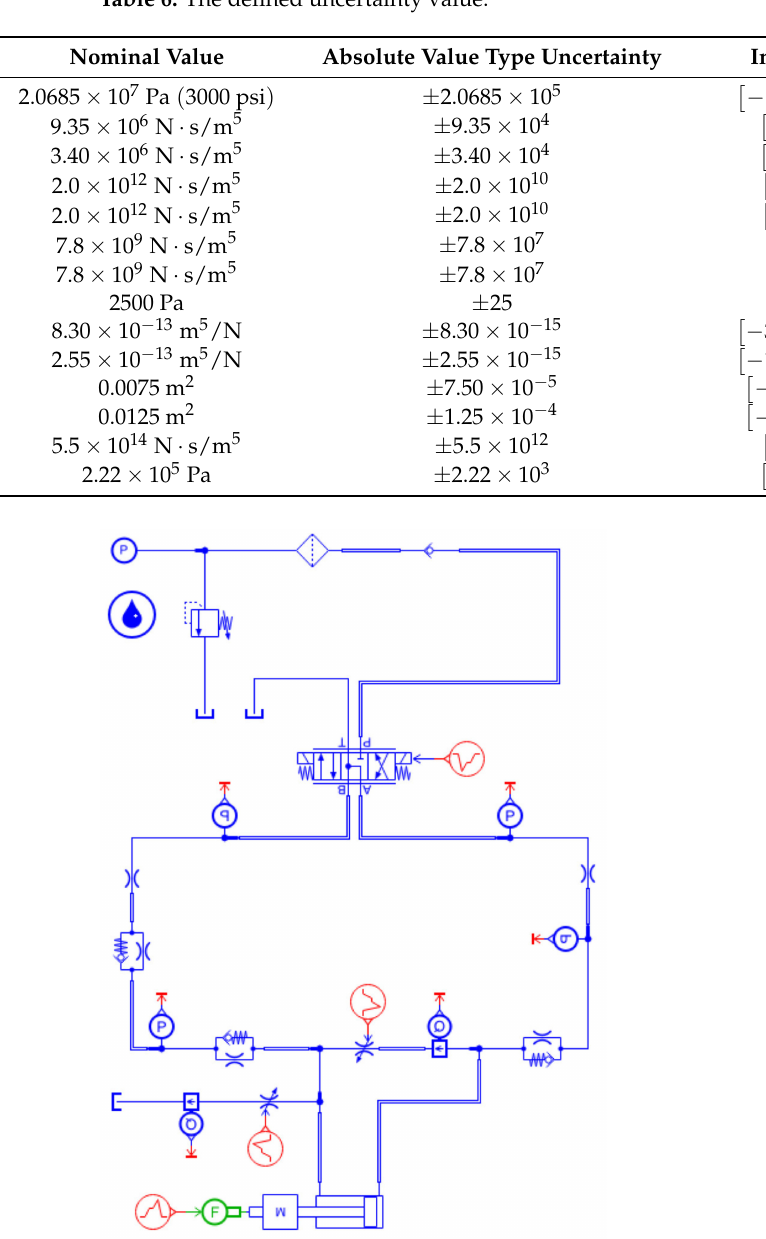
Table 6. The defined uncertainty value.